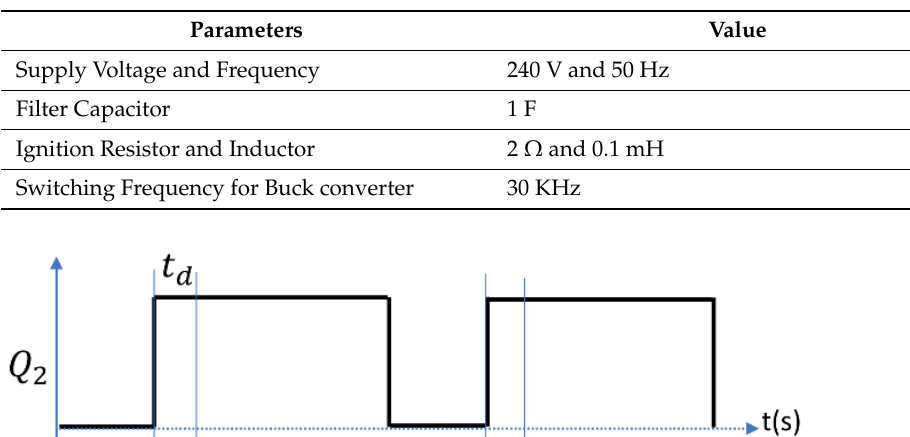
Table 1. Process parameters.